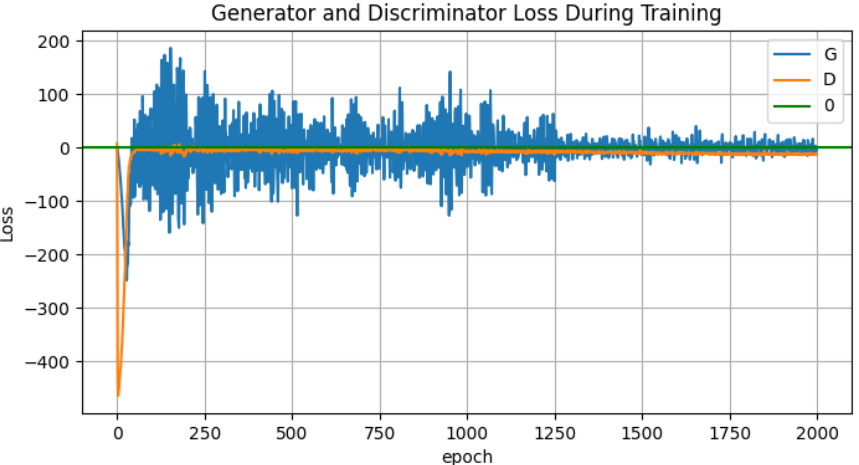
Figure 4. G/D loss function